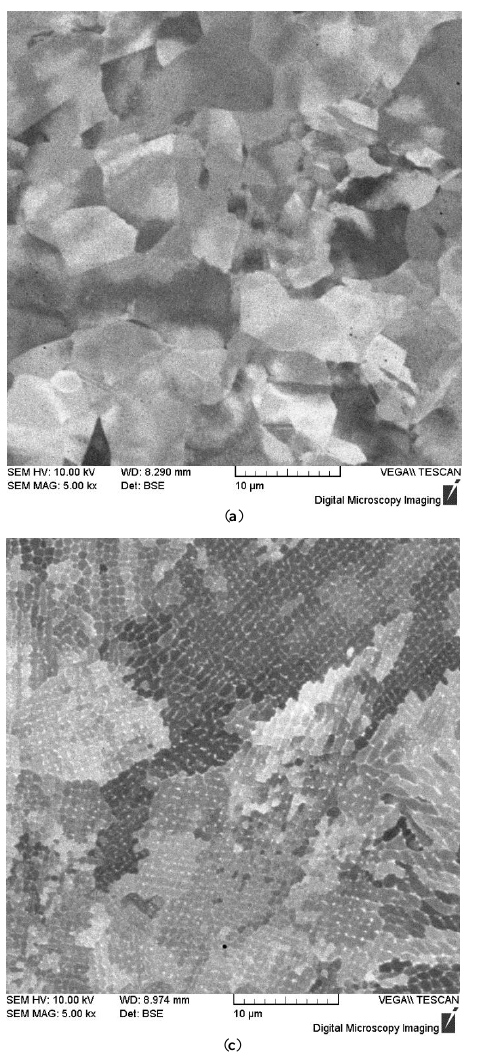
Figure 8. Microstructure of an Inconel 718 alloy cylindrical specimen (YZ plane) at different mag- nifications: (а) ×50: (b) ×500. Figures 9a,b show the characteristic microstructures obtained on the 316L steel specimens before and after the high temperature hydrogen permeability tests. The av- erage grain size was about 8 μm before the tests (Figure 9a). The microstructure of 316L steel was practically unchanged after high-temperature hydrogen permeability tests, а slight grain growth to an average size of 11 μm being observed (Figure 9b).